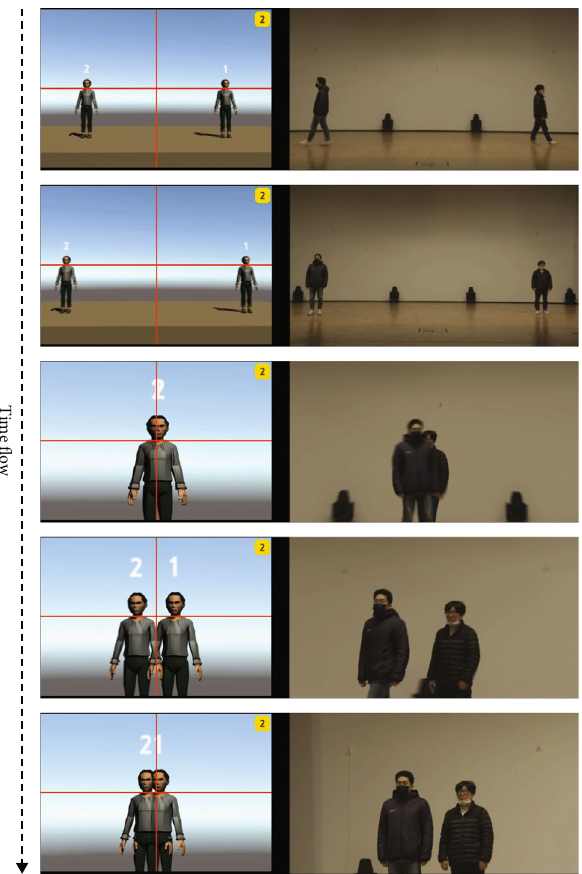
Figure 8: Magni fi cation value that changes as per the distance between two people and the tracking result as per the movement of two people (left: simulator, right: actual video).